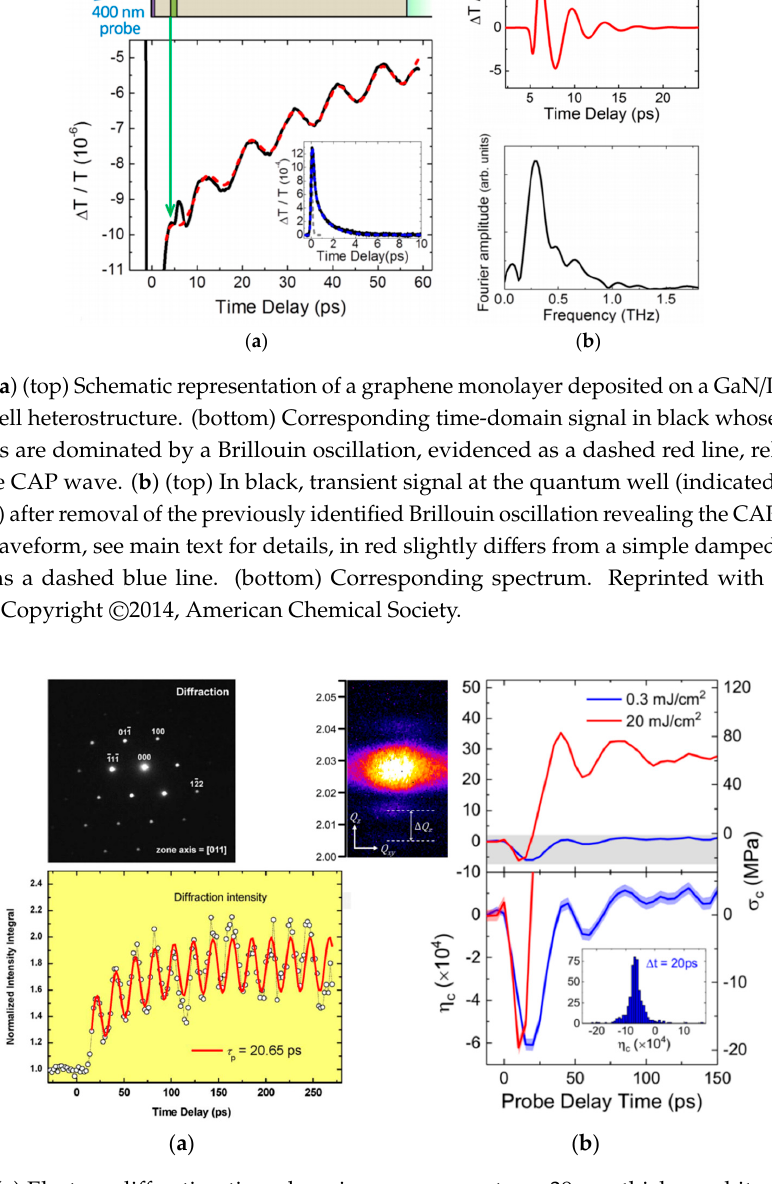
Figure 12. ( a ) Electron diffraction time-domain measurements on 39-nm-thick graphite where (top) diffraction spot intensity yields (bottom) an oscillating signal attributed to a breathing RCP mode. Reprinted from [124], Copyright ©2008, with permission from Elsevier. ( b ). X-ray diffraction time-domain measurements on a 50-nm-thick MoS 2 slab where (left) the spacing between Bragg spot fringes ∆ Q z yields (right) the transient out-of-plane strain (here η c = ∆ Q z / Q z ) represented for two different fluences. Oscillations corresponds to a breathing RCP mode. Reprinted with permission from [131]. Copyright ©2017, American Chemical Society.